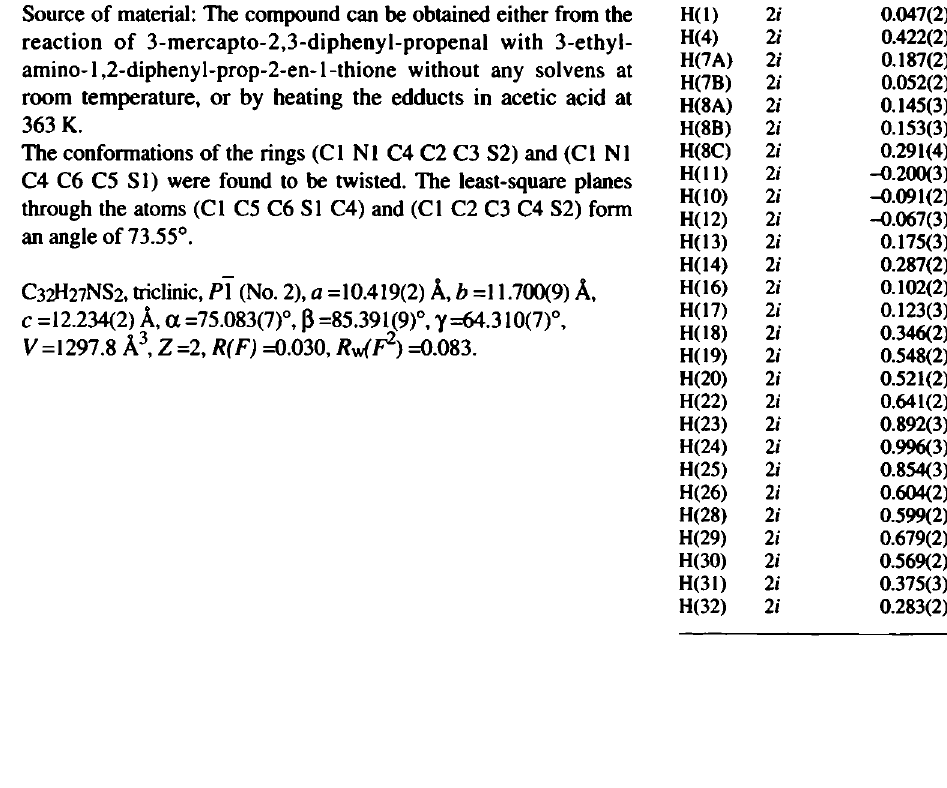
Table 2. Final atomic coordinates and displacement parameters (in A 2